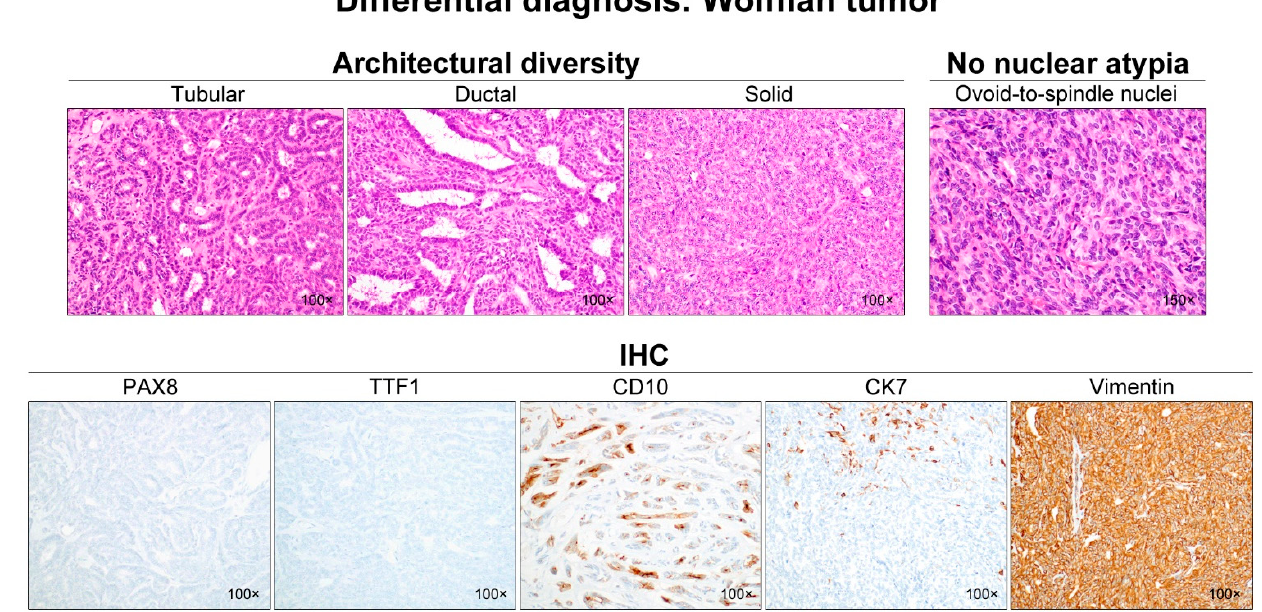
Figure 8. Differential diagnosis of ovarian MLA: Wolffian tumor. Note the variable architectural patterns including tubular, ductal, and solid. The latter pattern is characterized by a spindle cell population. The nuclei are bland, without nucleoli, and have a low mitotic count. The tumor cells of Wolffian tumors are completely negative for PAX8 and TTF1, which are usually expressed strongly by MLA cells. Luminal CD10 staining is similar to that observed in MLA. CK7 shows only focal staining, and vimentin immunoreactivity is diffuse and intense. The expression pattern of CK7 and vimentin in Wolffian tumors is different from that of most ovarian carcinomas, including MLA.